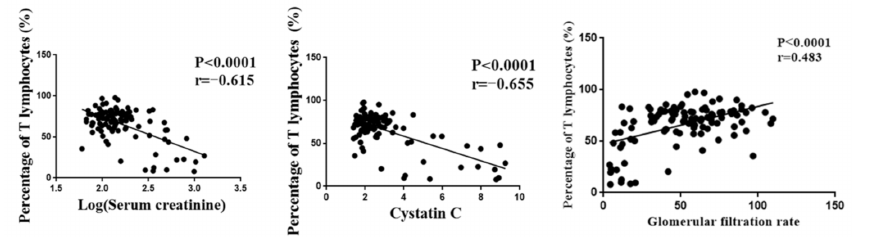
Figure 1. The correlation between T lymphocyte and renal function